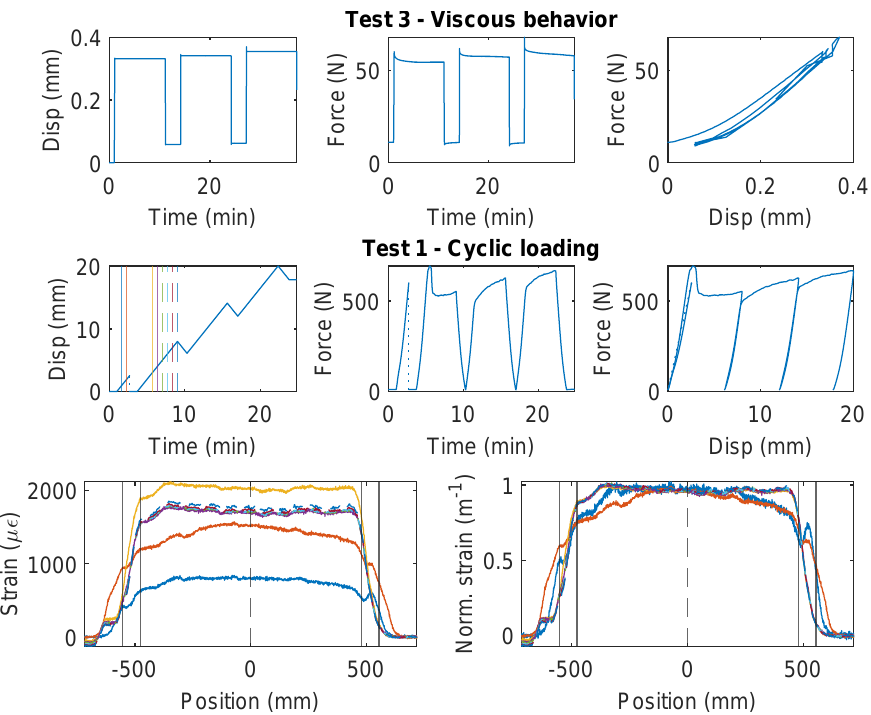
Figure 13. The loading protocol and force–displacement relation for Specimen 2 of the Stranded Steel 5.0 mm